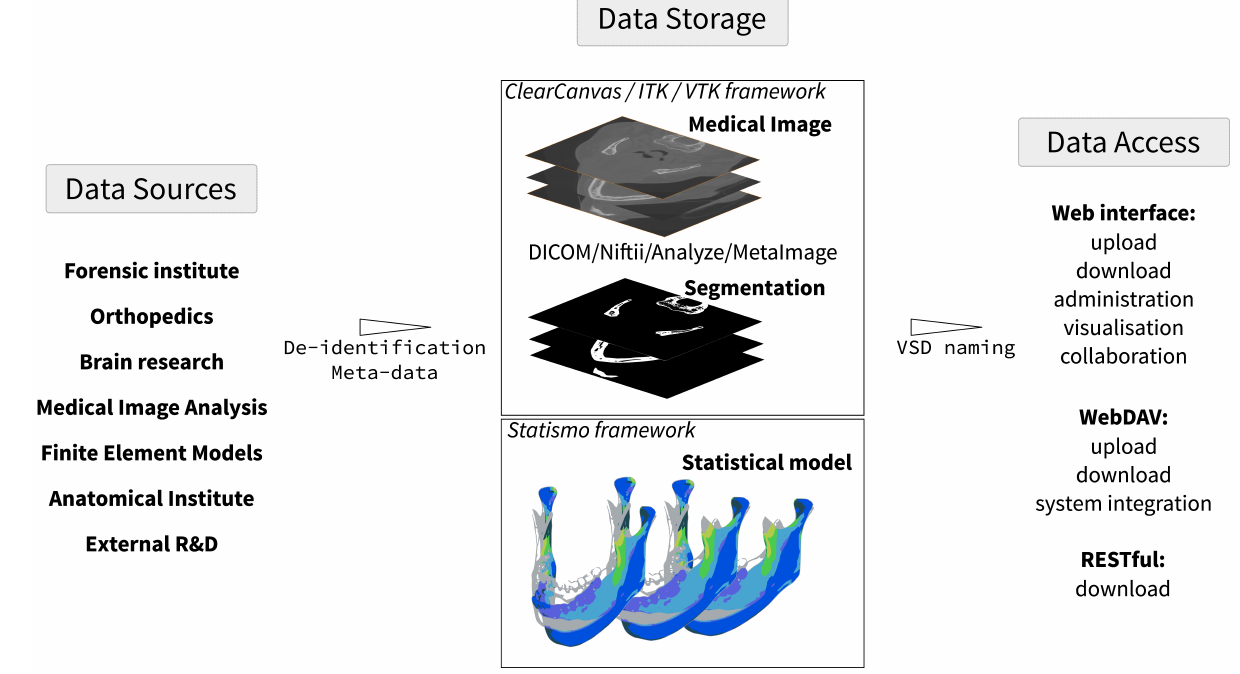
Figure 3. Conceptual overview of the VSD - data from various sources are stored in the VSD and can be accessed, organized, and